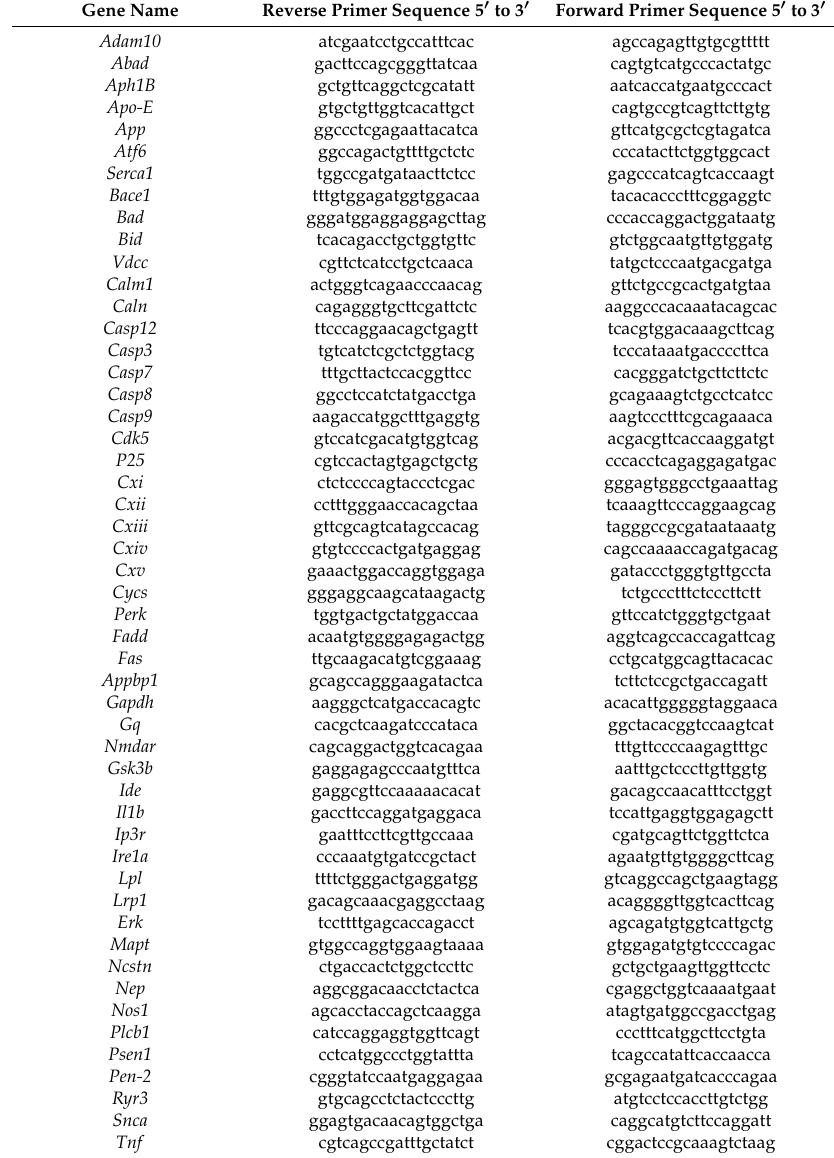
Table 1. Primer sequence of genes used for expression